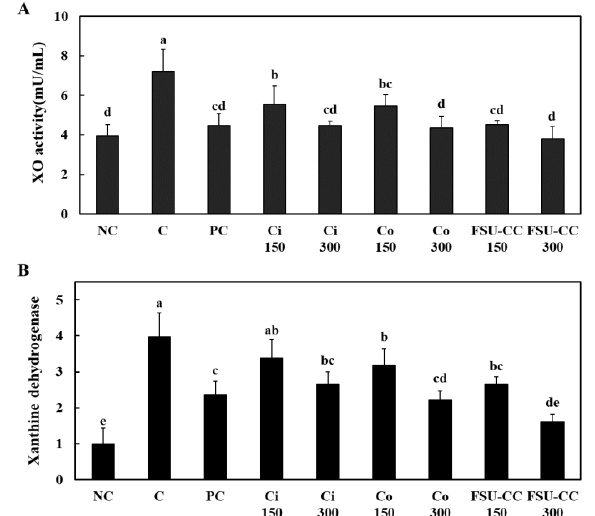
Figure 2. Xanthine oxidase activity ( A ) and xanthine dehydrogenase mRNA expression ( B ) in hypoxanthine-treated human liver cancer (HepG2) cells, with and without Ci, Co, or FSU-CC. NC: normal control, C: 4 mM hypoxanthine, PC: 4 mM hypoxanthine + 100 µ M allopurinol, Ci 150: 4 mM hypoxanthine + 150 μ g/mL Chrysanthemum indicum L., Ci 300: 4 mM hypoxanthine + 300 μg/mL C. indicum L., Co 150: 4 mM hypoxanthine + 150 μ g/mL Cornus officinalis Siebold and Zucc., Co 300: 4 mM hypoxanthine + 300 μ g/mL C. officinalis Siebold and Zucc., FSU-CC 150: 4 mM hypoxanthine + 150 μ g/mL mixture of C. indicum L. and C. officinalis Siebold and Zucc. (1:2), FSU-CC 300: 4 mM hypoxanthine + 300 μ g/mL mixture of C. indicum L. and C. officinalis Siebold and Zucc. (1:2). Different letters indicate significant difference at p < 0.05, as determined by Duncan’s multiple range test.